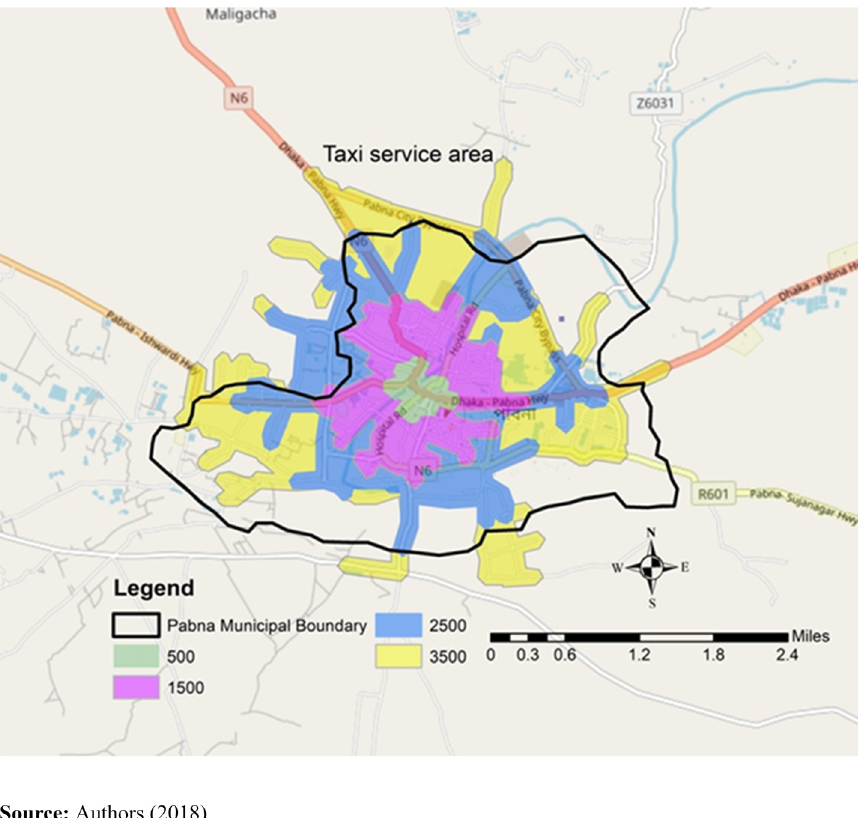
Figure 3. E-taxi service map in the study